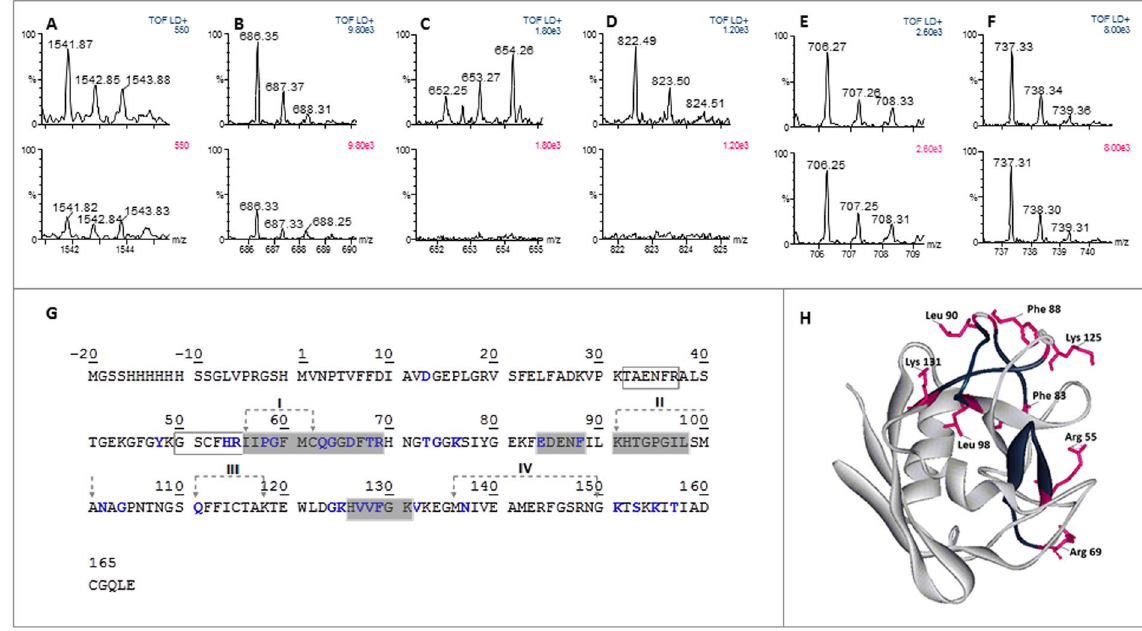
Figure 4. MALDI-TOF spectra of tryptic ( A , B ) and chymotryptic ( C , D ) CypA peptides protected from proteolysis following hydrolyses performed in the absence (upper panel) and in the presence (lower panel) of AIF(370-394) peptide. Representative CypA control peptides for which no relative intensity changes were detected are reported in ( E) (sequence region 50-55) and ( F) (sequence region 32-37). ( G ) Tryptic and chymotryptic peptides protected from proteolysis in the presence of AIF(370-394) peptide are grey shaded on CypA sequence. Amino acids identified by CSP-NMR and/or H/D-exchange are reported in blue. Moreover, the regions I-IV identified by Candé et al . 13 are indicated on the sequence. Control tryptic peptides showed in E , F are boxed. ( H ) Tryptic and chymotryptic peptides protected from proteolysis in the presence of AIF(370- 394) peptide and amino acids in the close proximity of these peptides are also highlighted in the CypA structure (PDB ID 1OCA) 28 in blue and pink,